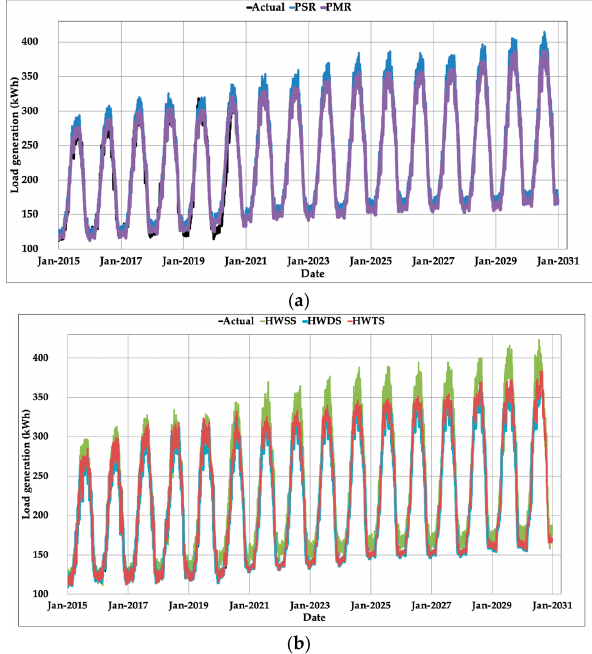
Figure 2. The generation of daily loads data in Kuwait: the trained, predicted, and forecasted data using the five models of ( a ) two types of the Prophet model and ( b ) three types of the Holt-Winters model.